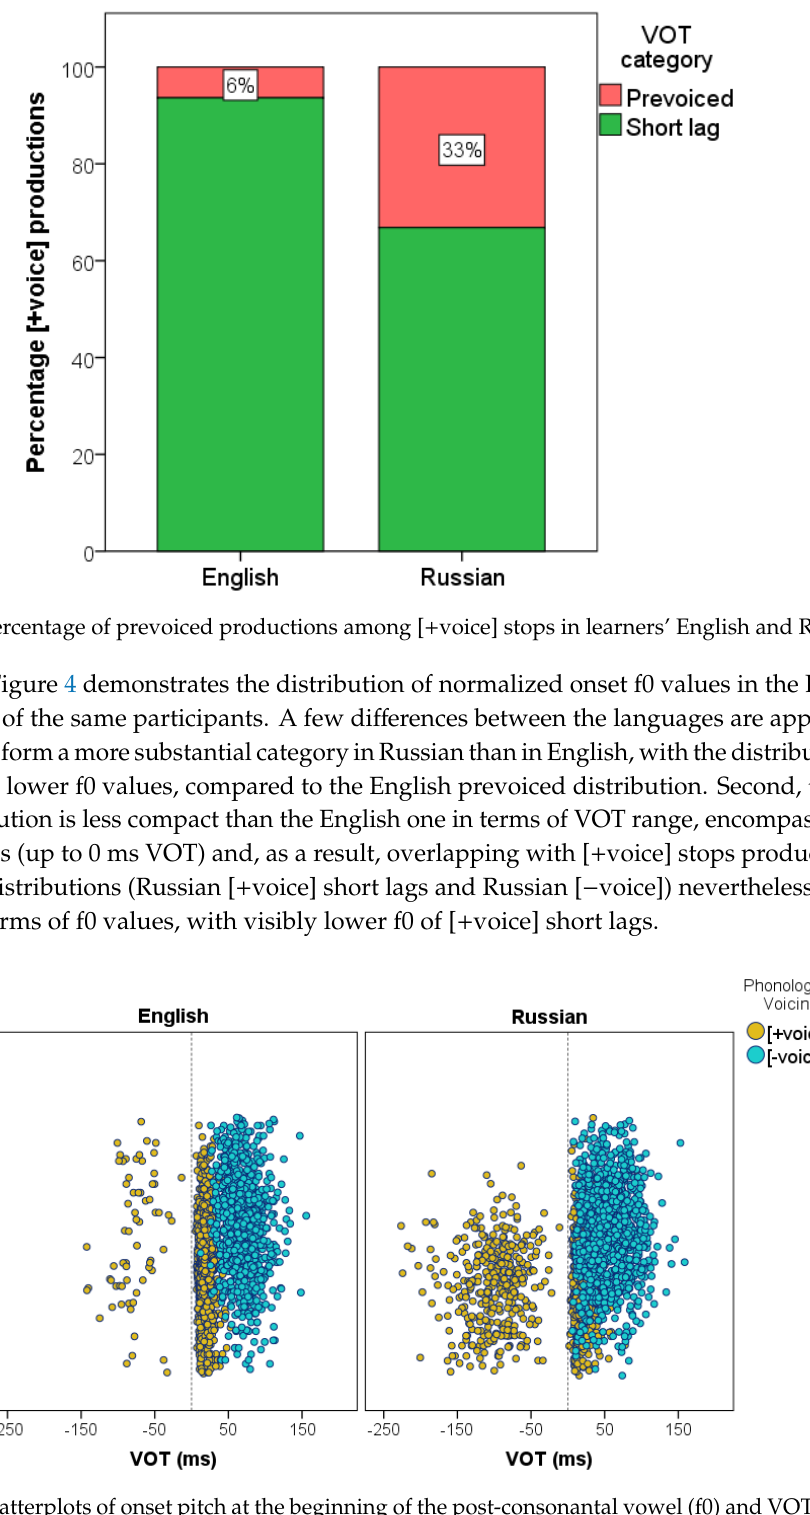
Figure 4. Scatterplots of onset pitch at the beginning of the post-consonantal vowel (f0) and VOT values for learners’ English and Russian initial stops.